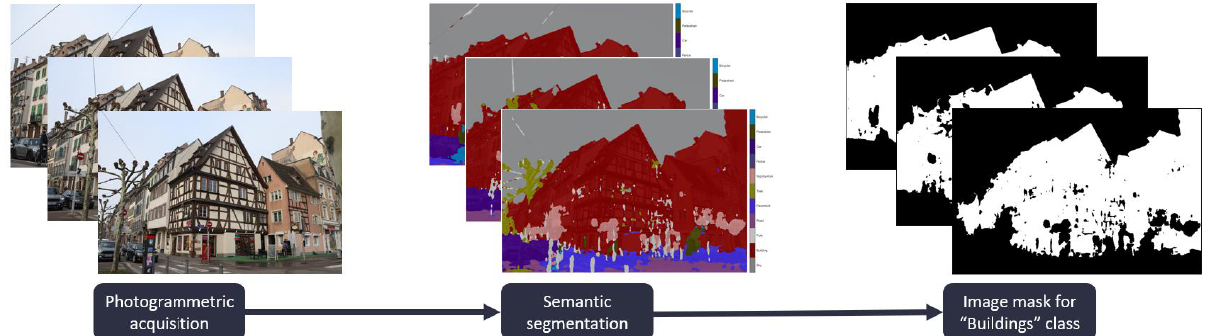
Figure 1. General workflow of the proposed method by creating 2D masks excluding unwanted classes to be used during dense image